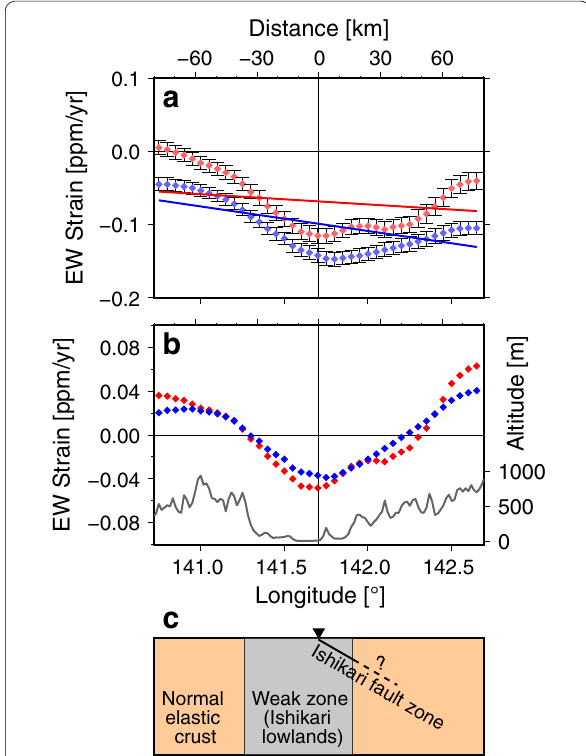
Fig. 4 Profiles of the E–W strain rate components at a latitude of 43.0°N. a The original E–W strain rate component. Red and blue colors represent estimates of March 1996 to September 2003 (period 1) and January 2014 to December 2017 (period 2), respectively. Error bars are 1 σ. Each colored line is the result of the linear trend fitting − performed on each profile. b Detrended strain rate profile. The lower grey line corresponds to the altitude along the profile. c Schematic image beneath the profile